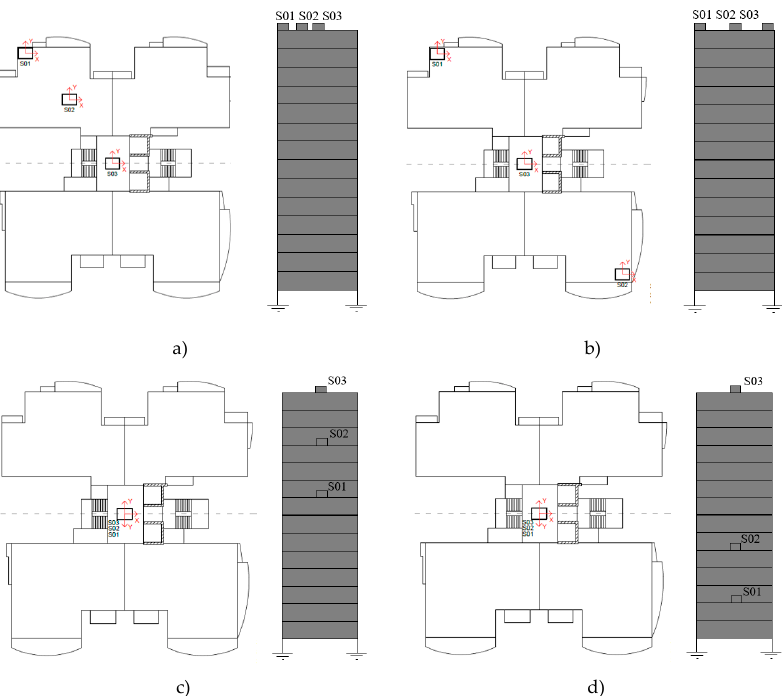
Figure 7. Ambient vibration tests: schematic layout of the seismometers disposition ( a ) Setup 1; ( b ) Setup 2; ( c ) Setup 3, and ( d ) Setup 4.